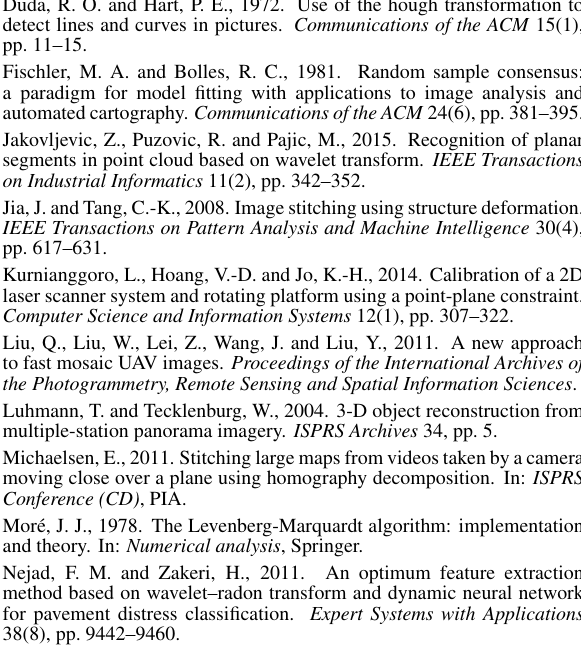
(d) Stitched panorama with the business software “PTGui”